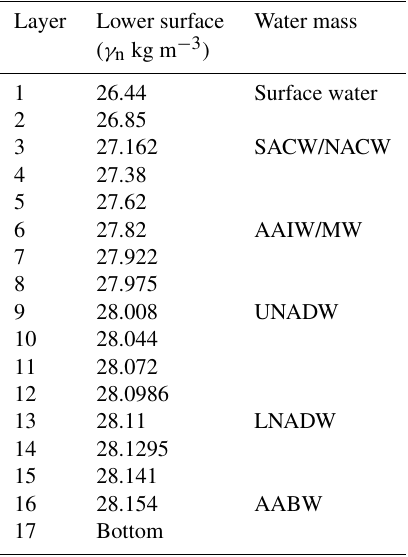
Table 1. Neutral density surfaces ( γ n kgm − 3 ) that separate the lay- ers in the box inverse model. The water masses are labeled to the approximately corresponding